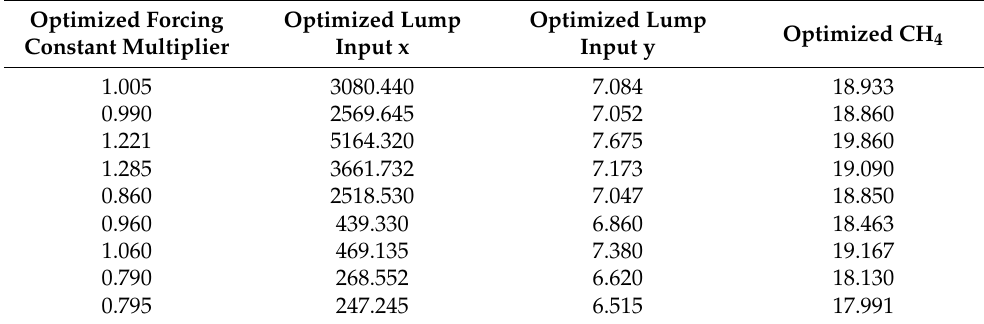
Table 6. Sample of optimized lump input parameter from test data set and optimized modeled methane for the biogas digester.